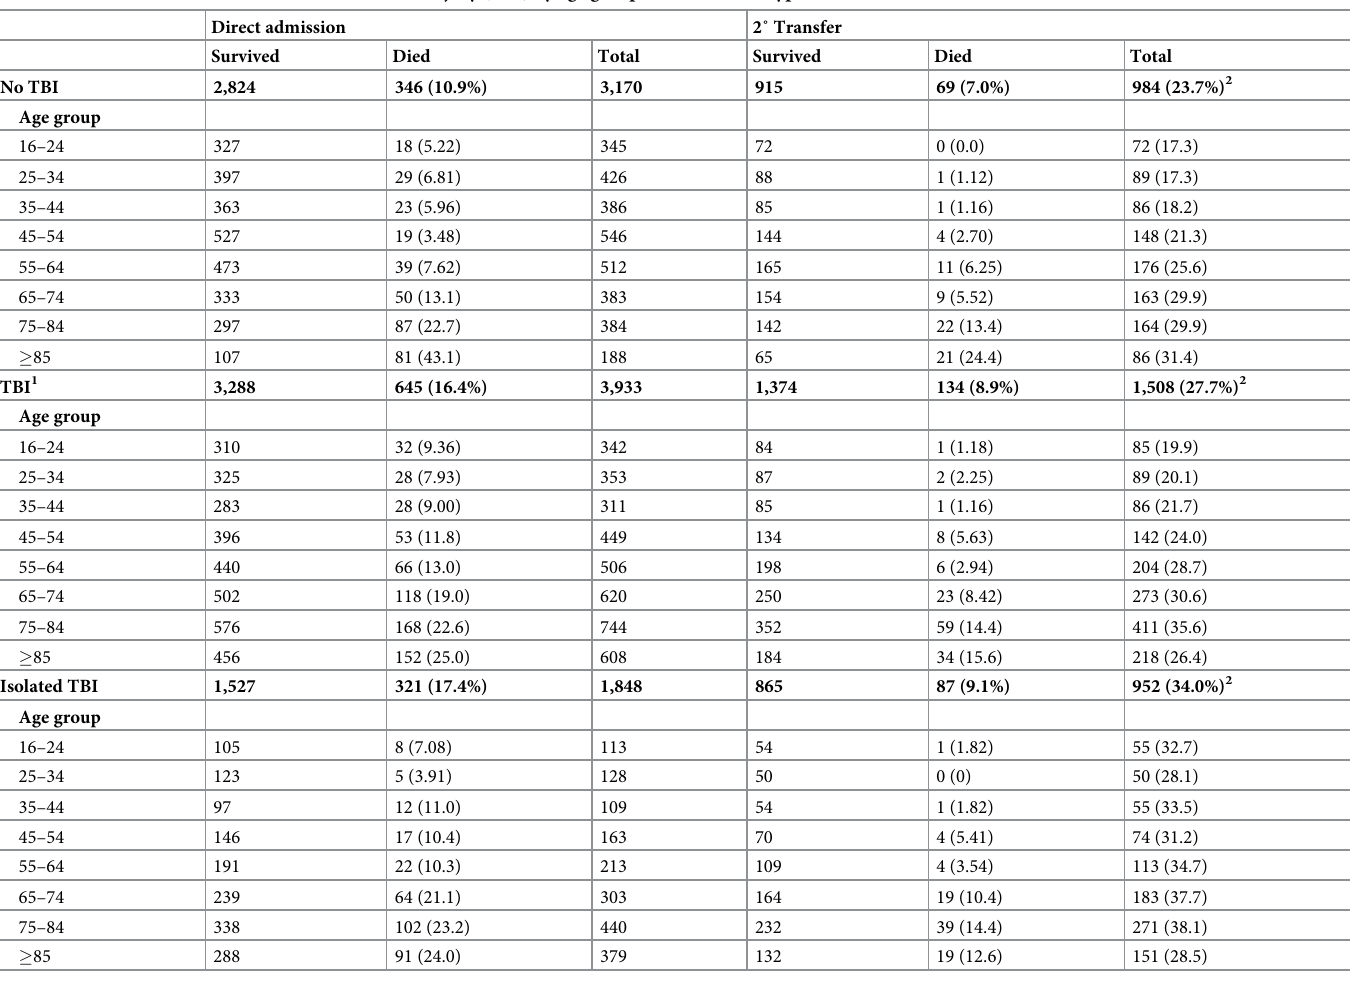
Table 2. Patients with and without traumatic brain injury (TBI) by age group and admission